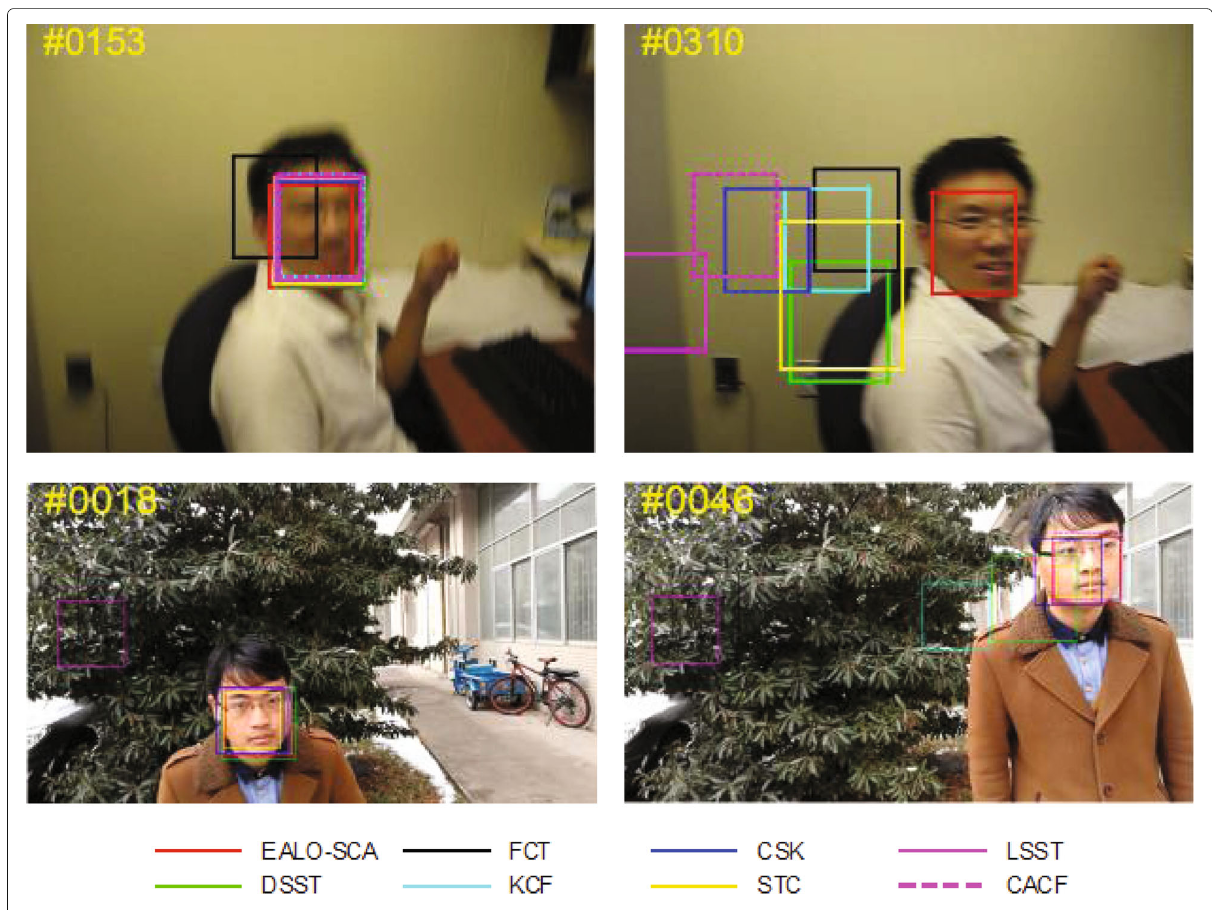
Fig. 1 Example tracking results of different methods. Sequence 1–2: BLURFACE, ZT